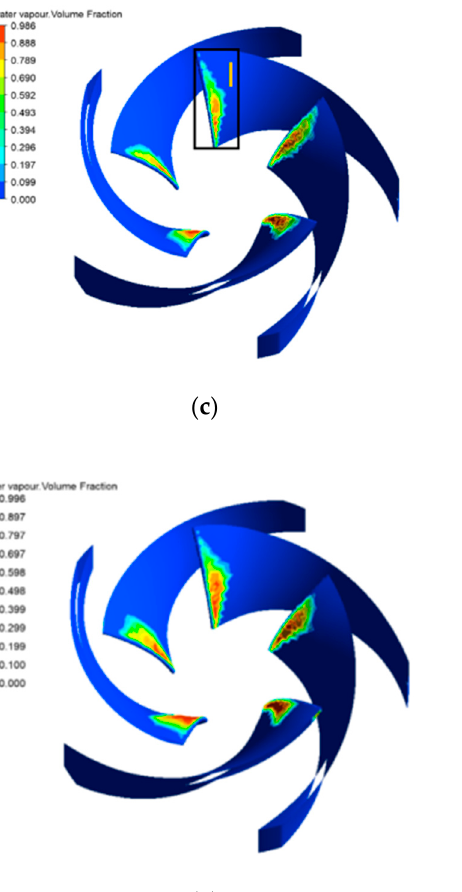
Table 11. Variation in vapor volume fraction. Vapor Volume Fraction Inlet Pressure (kPa) Origin Optimal